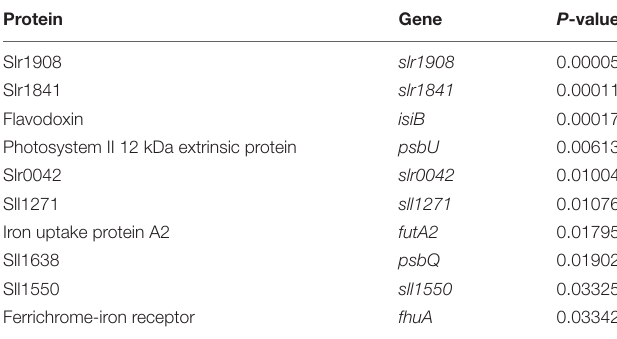
TABLE 2 | Reciprocal effect of copper and iron on protein